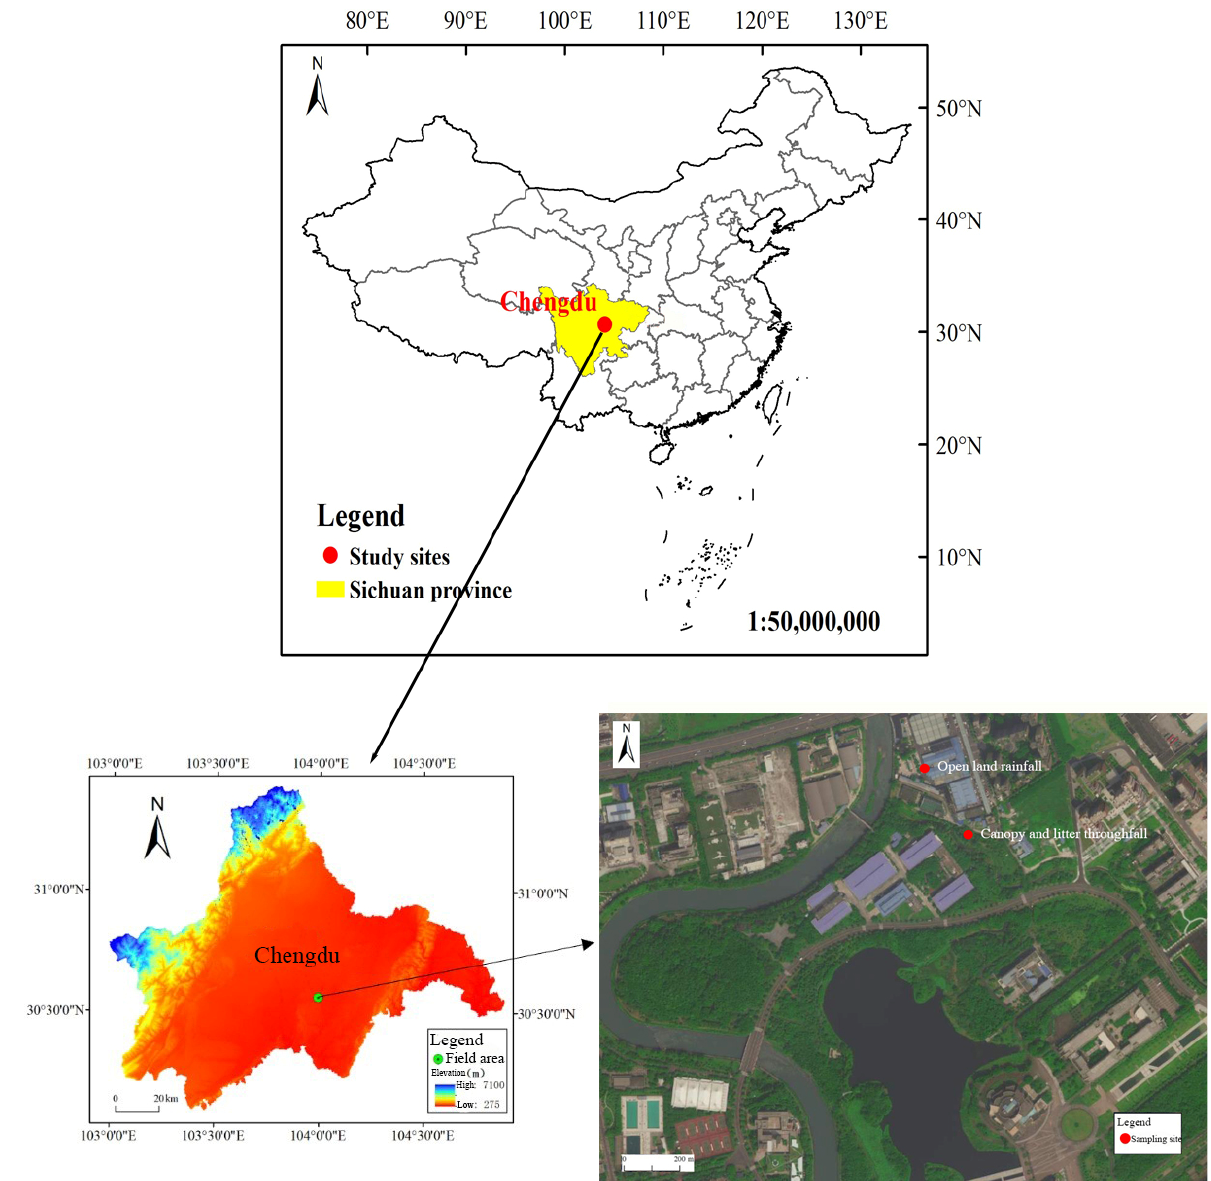
Figure 1. Geographical location of the study area.